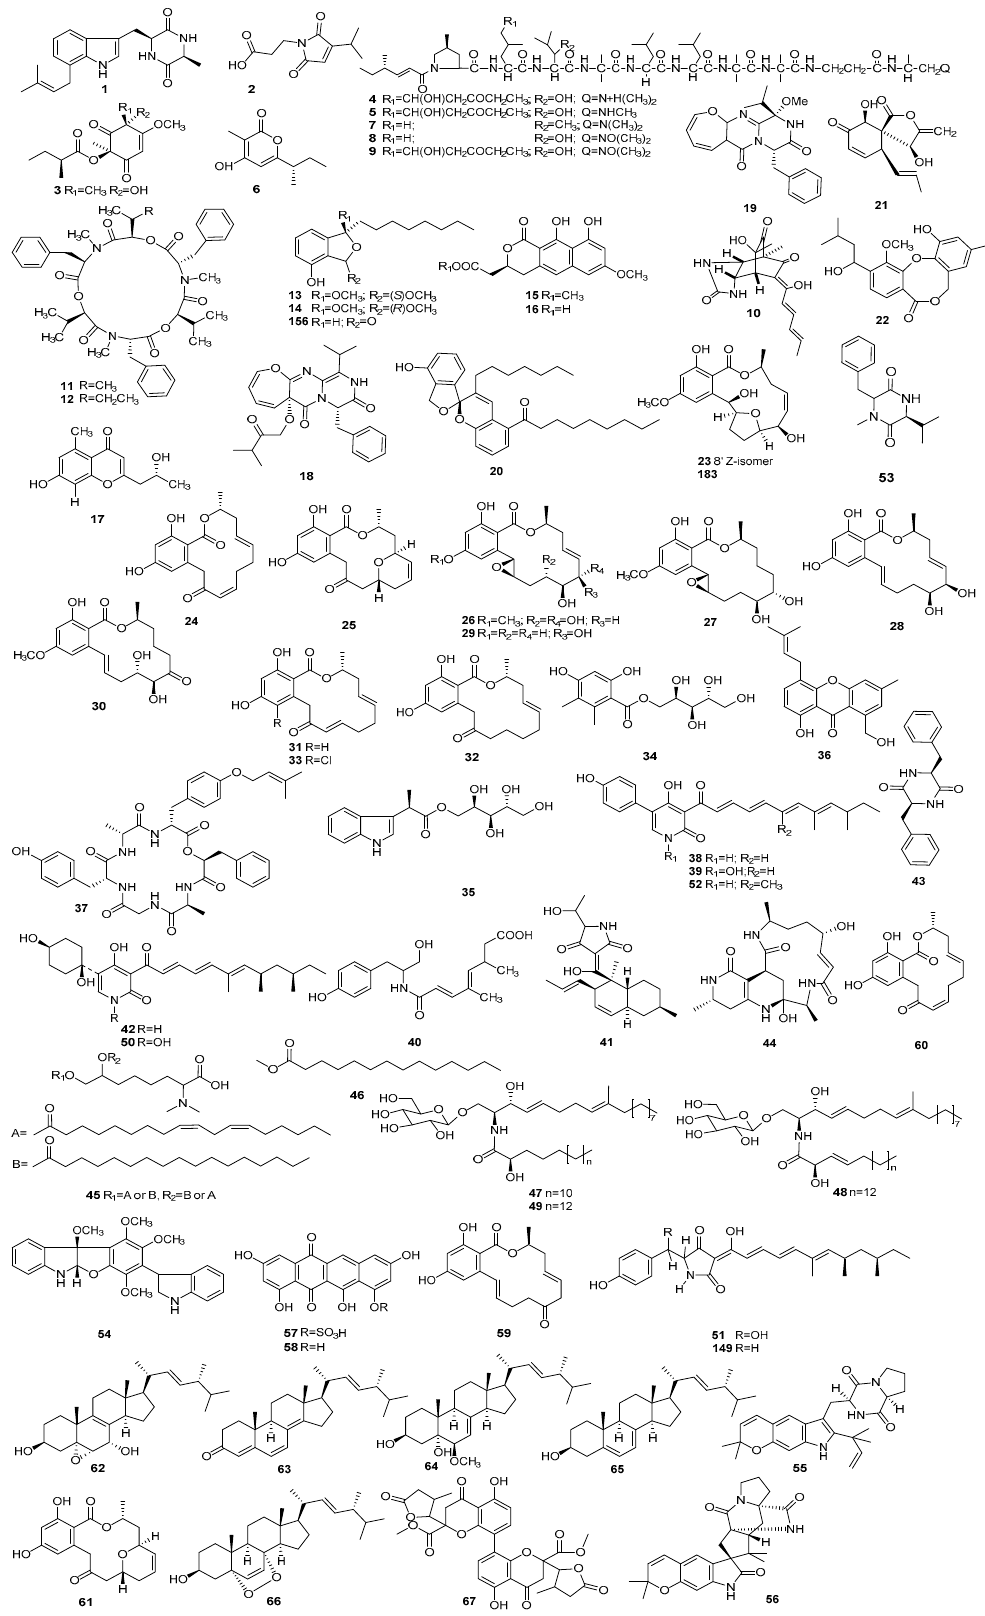
Figure 1. The structures of metabolites produced by Paecilomyces ( 1 ).